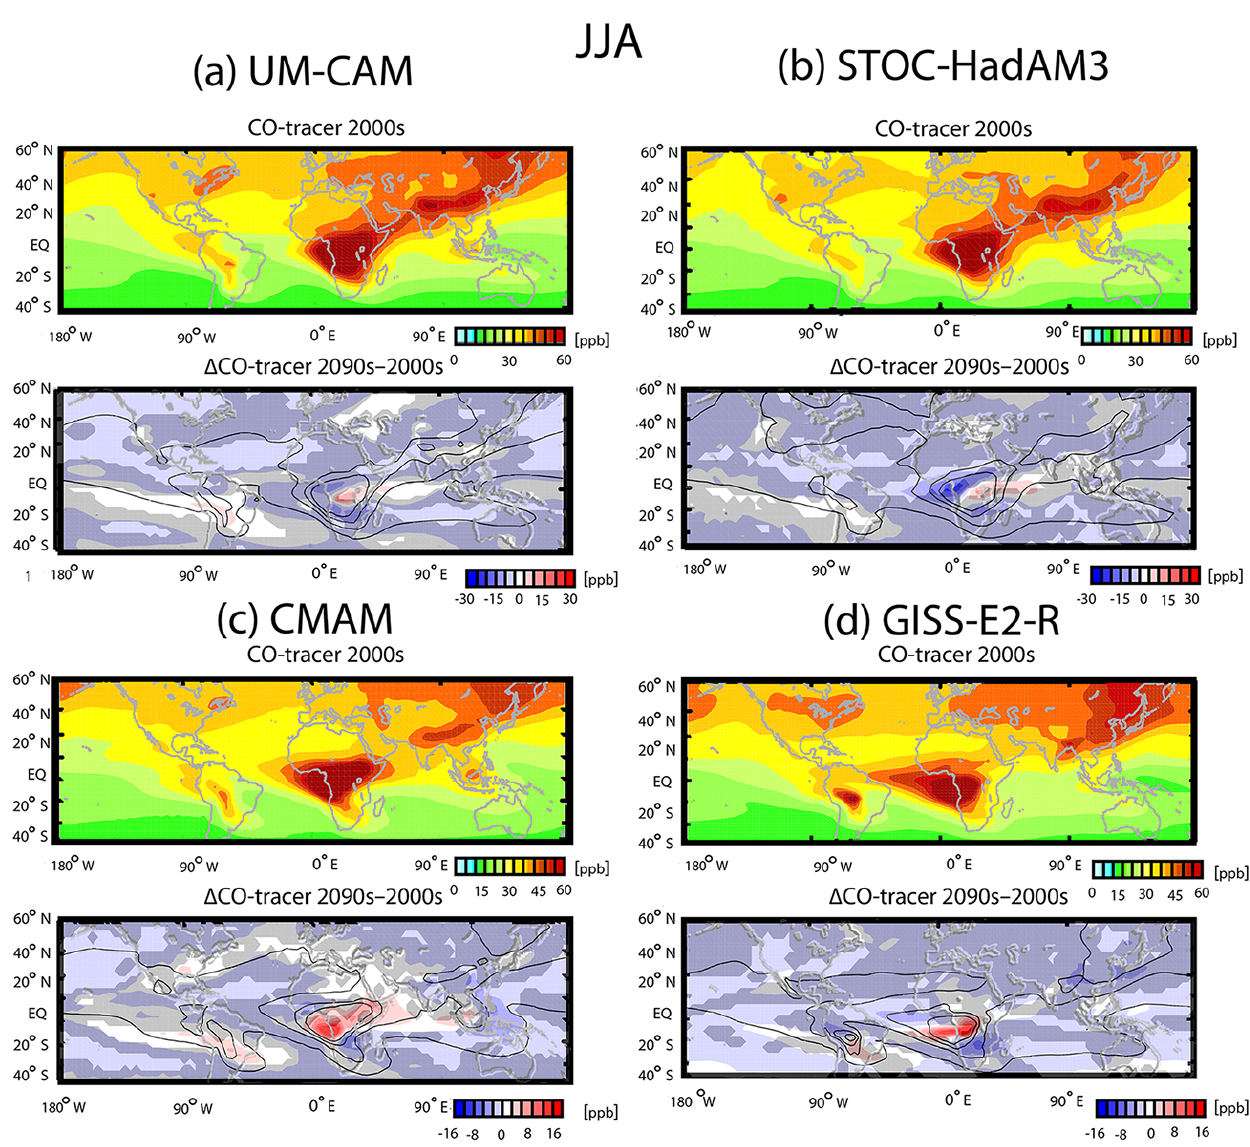
Figure 5. Same as Fig. 4 but for JJA. Note the different scales for (i) UM-CAM and STOC-HadAM3 and (ii) CMAM and GISS-E2-R for the difference